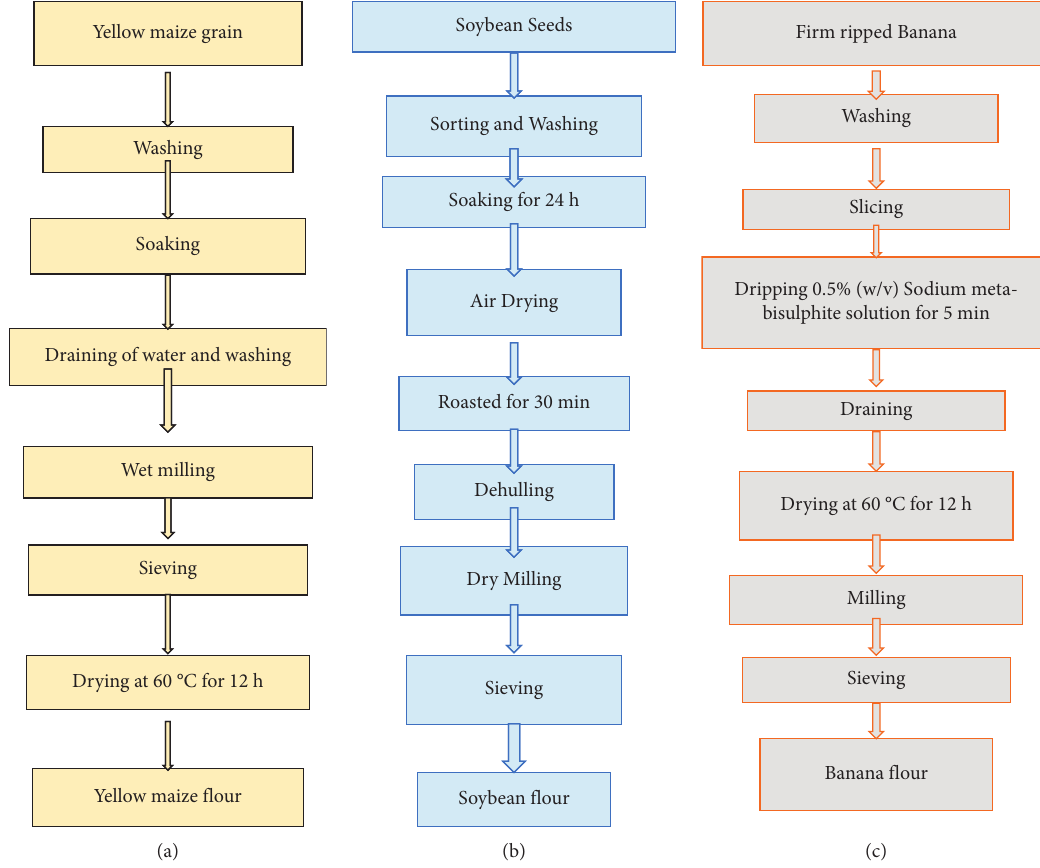
Figure 2: Adopted flow diagrams for the production of maize flour [18–20], soybean flour [18, 21, 22], and banana flour [18,